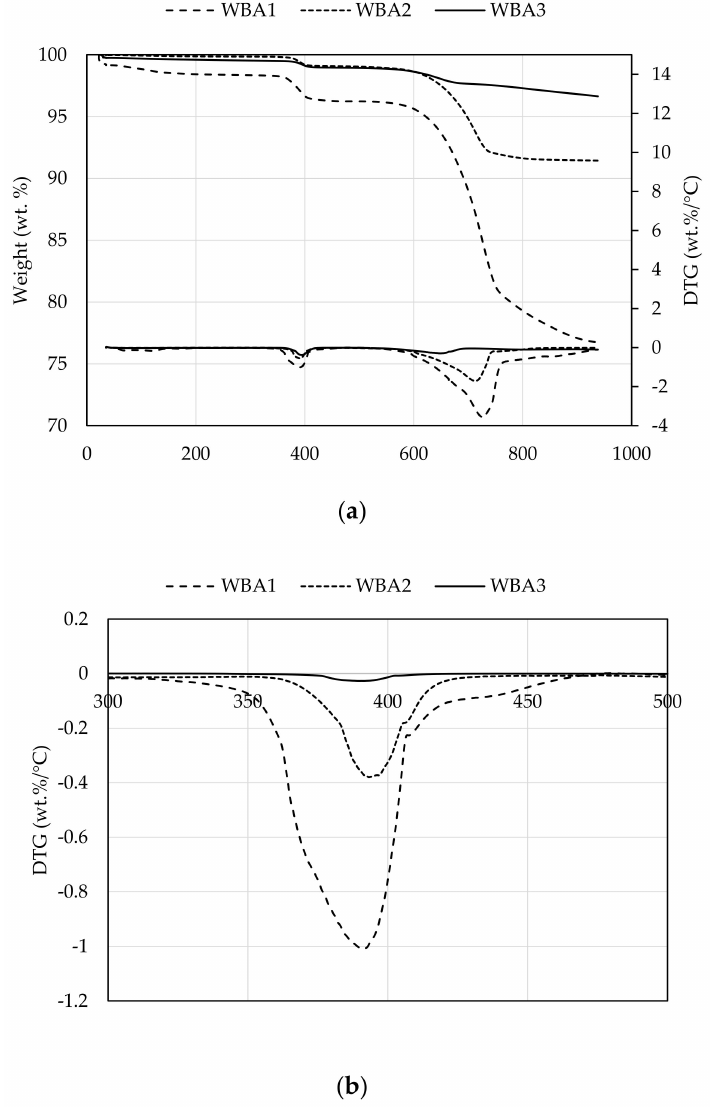
Figure 3. ( a ) TGA and DGT of WBA samples; ( b ) Detailed DTG curve for WBA